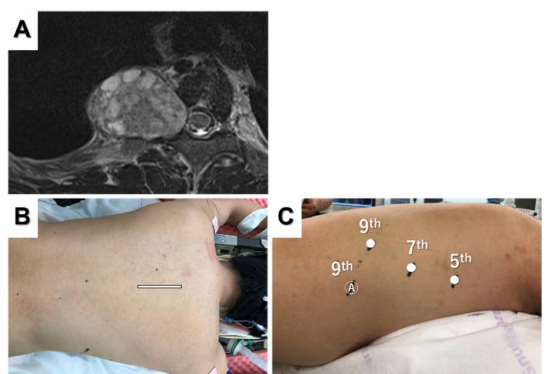
Figure 4. Magnetic resonance image showing a posterior mediastinal dumbbell tumor ( A ). The posterior incision ( B ) and port placement for robotic tumor resection ( C ) are shown.